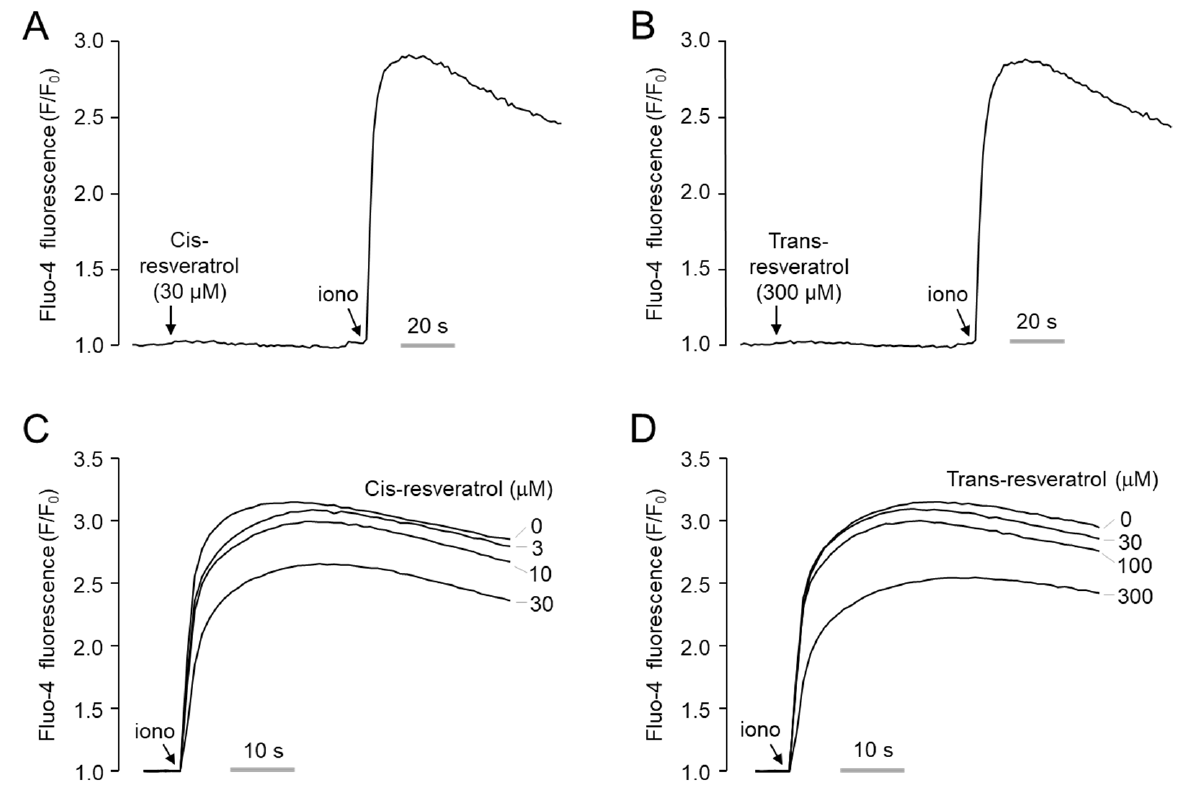
Figure 3. Effect of cis - and trans -resveratrol on intracellular calcium levels in PC-3 cells. ( A , B ) Intracellular calcium levels were measured using Fluo-4 NW. Cells were treated with the indicated concentrations of cis - and trans -resveratrol and stimulated with 10 µ M ionomycin. ( C , D ) Cells were pretreated with the indicated concentrations of cis - and trans -resveratrol for 10 min, followed by stimulation with 10 µ M ionomycin .